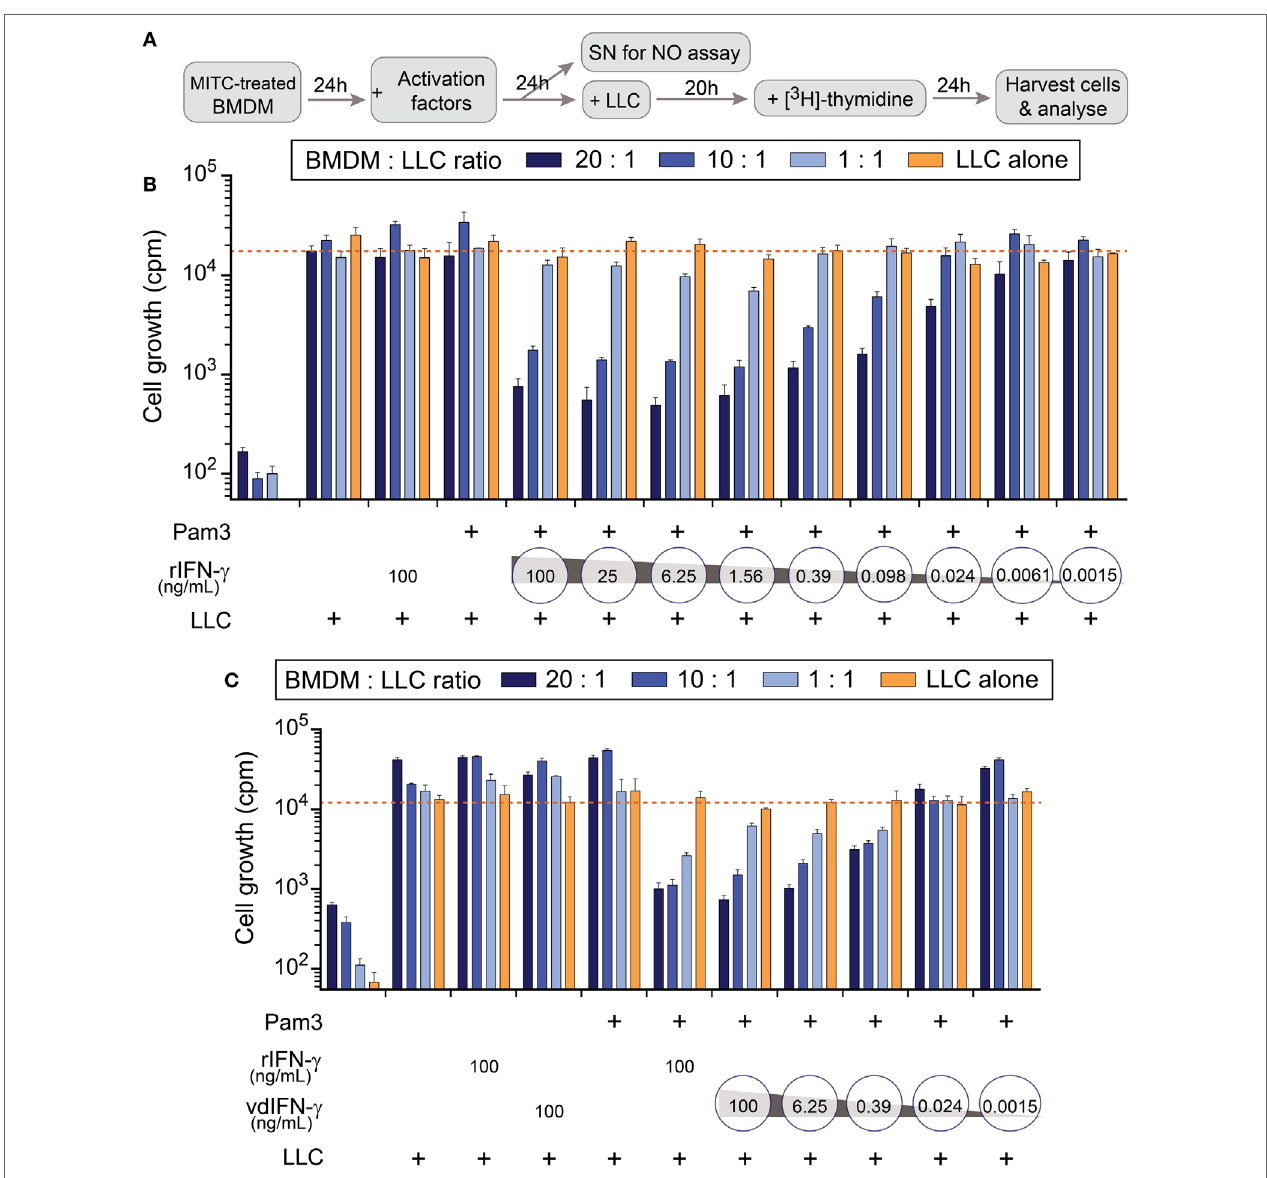
FigUre 9 | The effect of rIFN- γ or vdIFN- γ in combination with a TLR2/1 ligand on macrophage activation was detected using growth inhibition assay in Lewis lung carcinoma (LLC) cells. (a) Schematic timeline of the experiment. Mitomycin C-treated bone marrow-derived macrophages (BMDMs) were plated at three different densities and incubated for 24 h before macrophage-stimulating factors were added. After an additional 24 h, 100 µL of cell culture media was obtained from the wells with the highest macrophage density to measure NO 2 − levels. LLC cells were added to the activated BMDMs, and the co-cultures were incubated for an additional 20 h. [ 3 H]-thymidine was then added to the co-cultures, and after 24 h, the LLC cells were harvested to analyze cell growth by measuring the amount of incorporated [ 3 H]-thymidine as counts per minute (cpm, depicted on the y -axis). (B) LLC cell growth after co-cultivation with BMDMs that were activated with Pam3 (100 ng/mL) in combination with different concentrations of rIFN- γ ranging from 100 to 0.0015 ng/mL in fourfold dilutions. Controls, from left to right: BMDMs cultivated without LLC cells, LLC cells co-cultivated with unstimulated macrophages, and LLC cells co-cultivated with macrophages that were stimulated with either rIFN- γ alone or Pam3 alone. (c) LLC cell growth after co-cultivation with BMDMs that were activated with Pam3 (100 ng/mL) in combination with vdIFN- γ ranging from 100 to 0.0015 ng/mL in 16-fold dilutions. Controls, from left to right: BMDMs cultivated without LLC cells, LLC cells co-cultivated with unstimulated macrophages, LLC cells co-cultivated with macrophages that were treated with either rIFN- γ , vdIFN- γ , or Pam3 at a concentration of 100 ng/mL, and LLC cells co-cultivated with BMDMs that were treated with 100 ng/mL of both rIFN- γ and Pam3. Experiments were performed in triplicates and were repeated two times with similar results. The bars represent the mean values of triplicates ± SEM from one representative